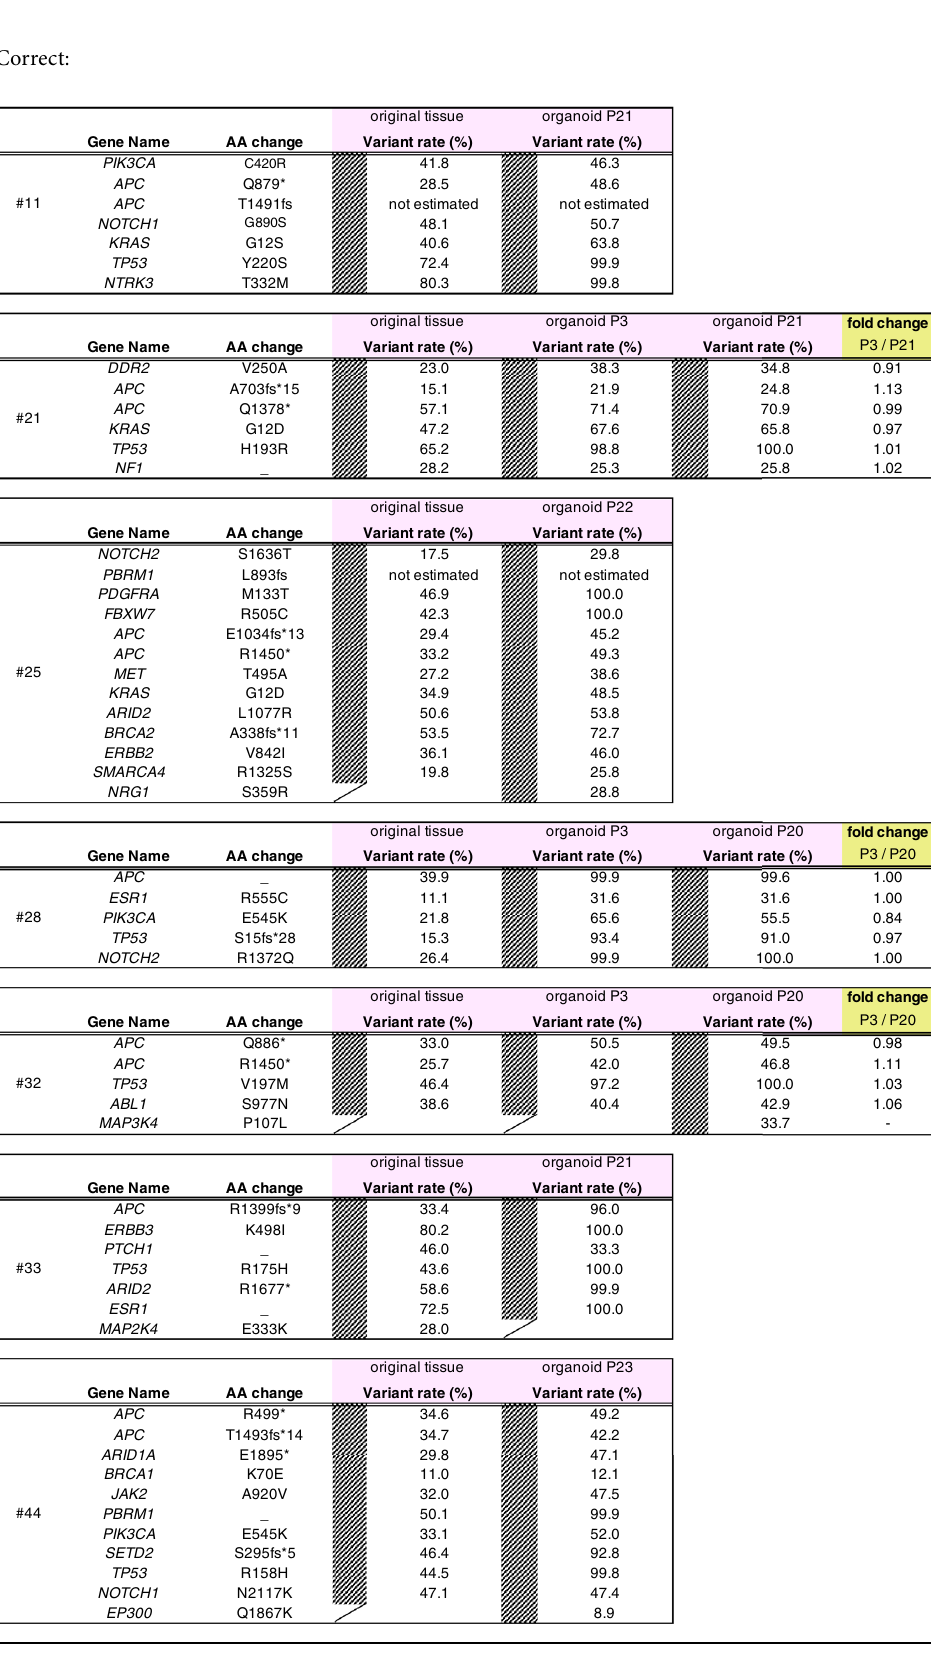
Table 1. Comparison of variant rates of cancer-associated genes between original tumor tissues and organoids of principal 7